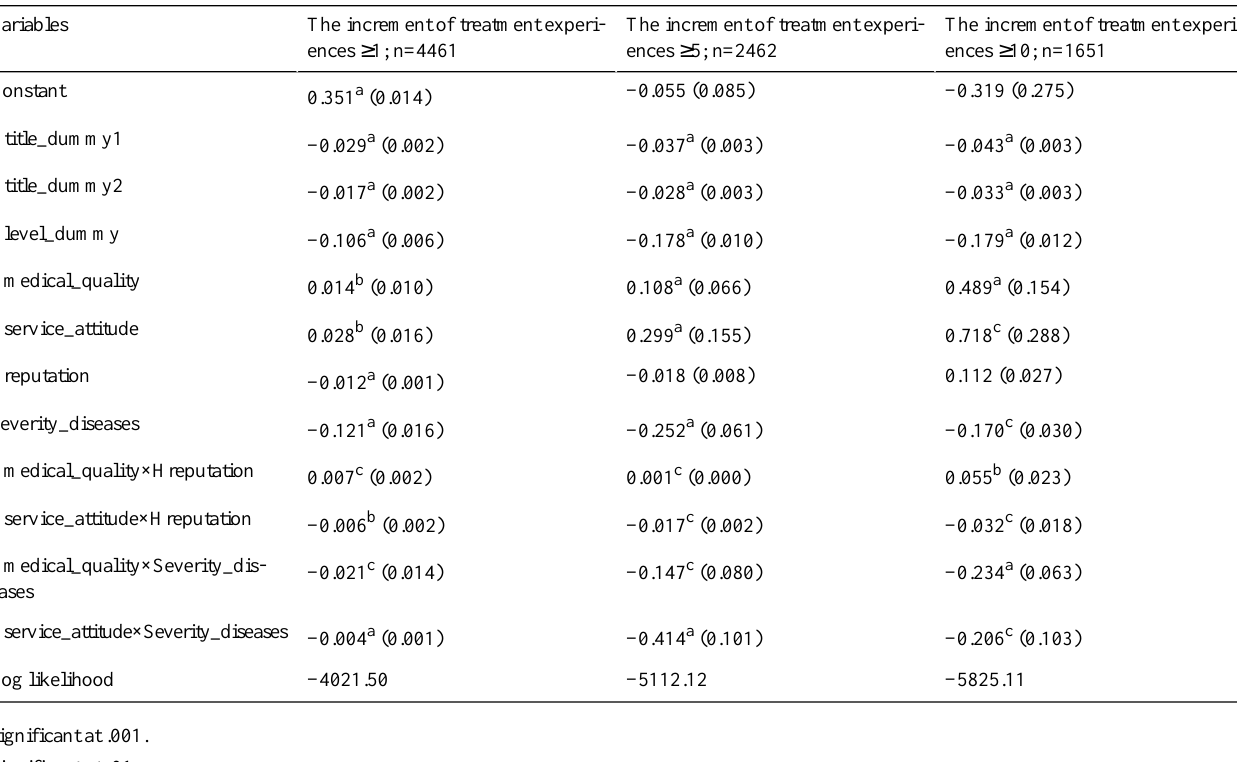
Table 5. Robustness check results. General linear model regression was used to obtain results.